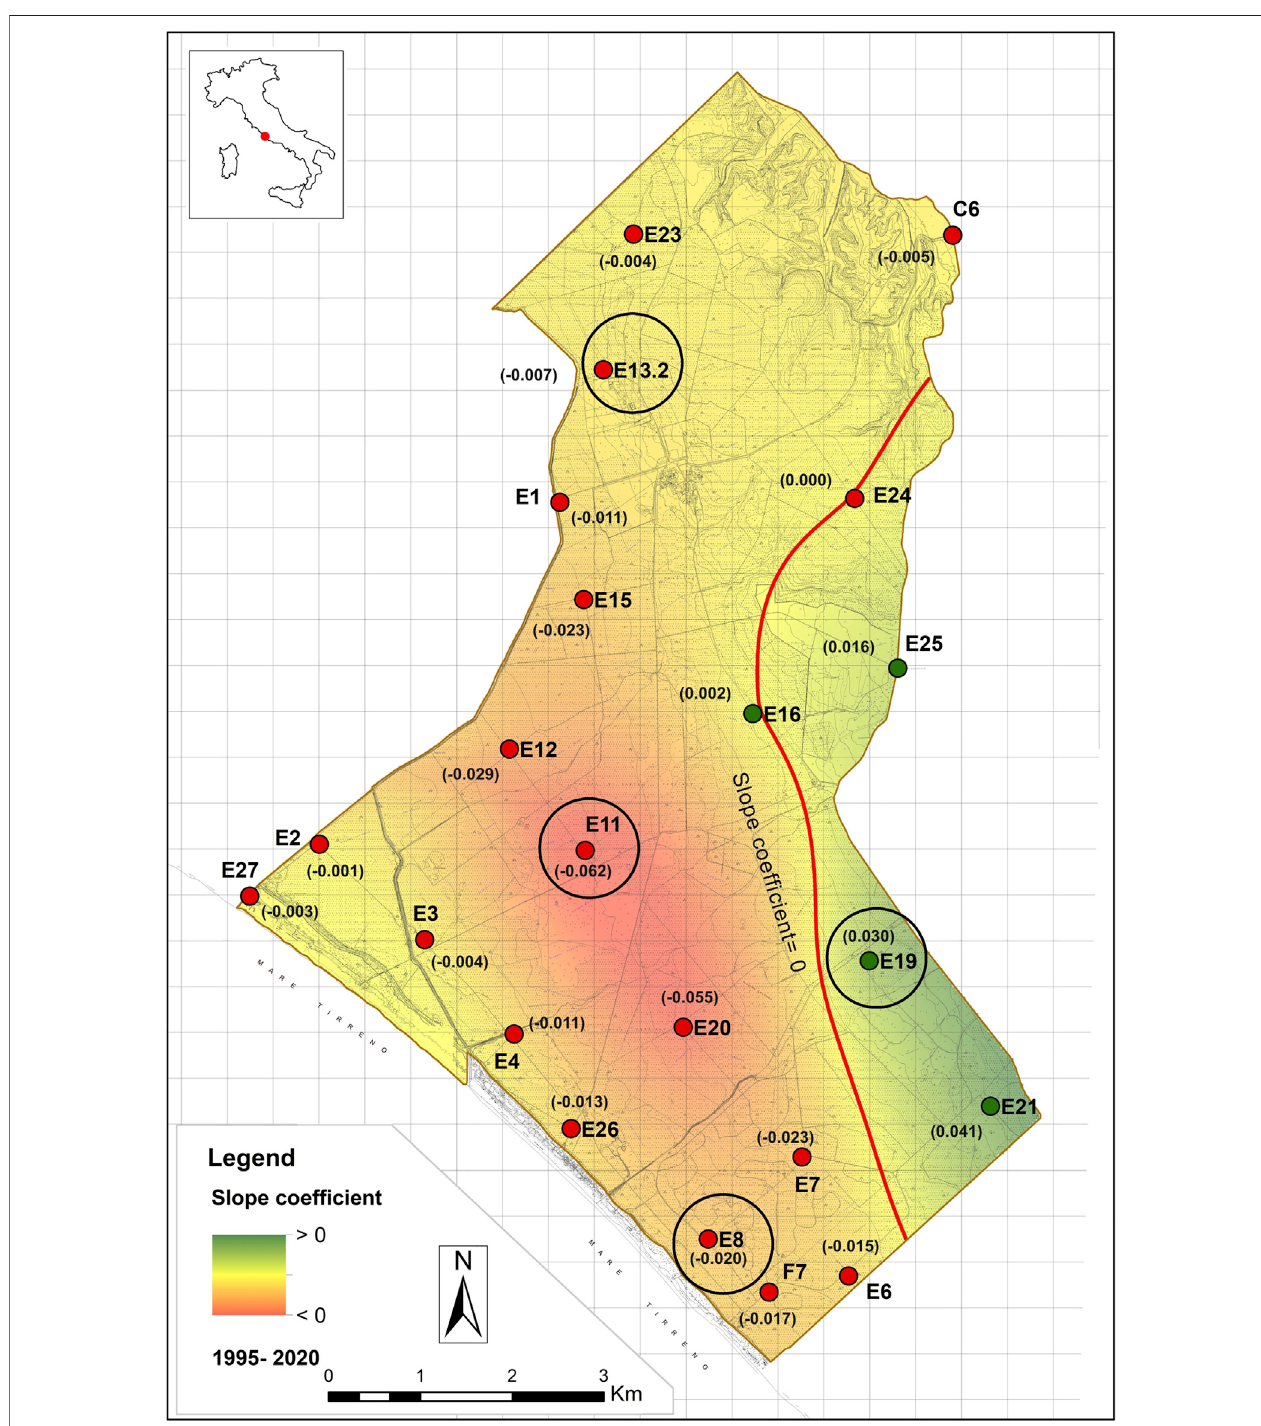
FIGURE 4 | Distribution map of the slope coef fi cient of the water level trends calculated for the 1995 – 2020 monitoring period in 22 monitoring wells. Values in brackets represent the slope coef fi cient calculated for each monitoring well. Black circles identify the location of representative monitoring wells shown in Figure 3 .